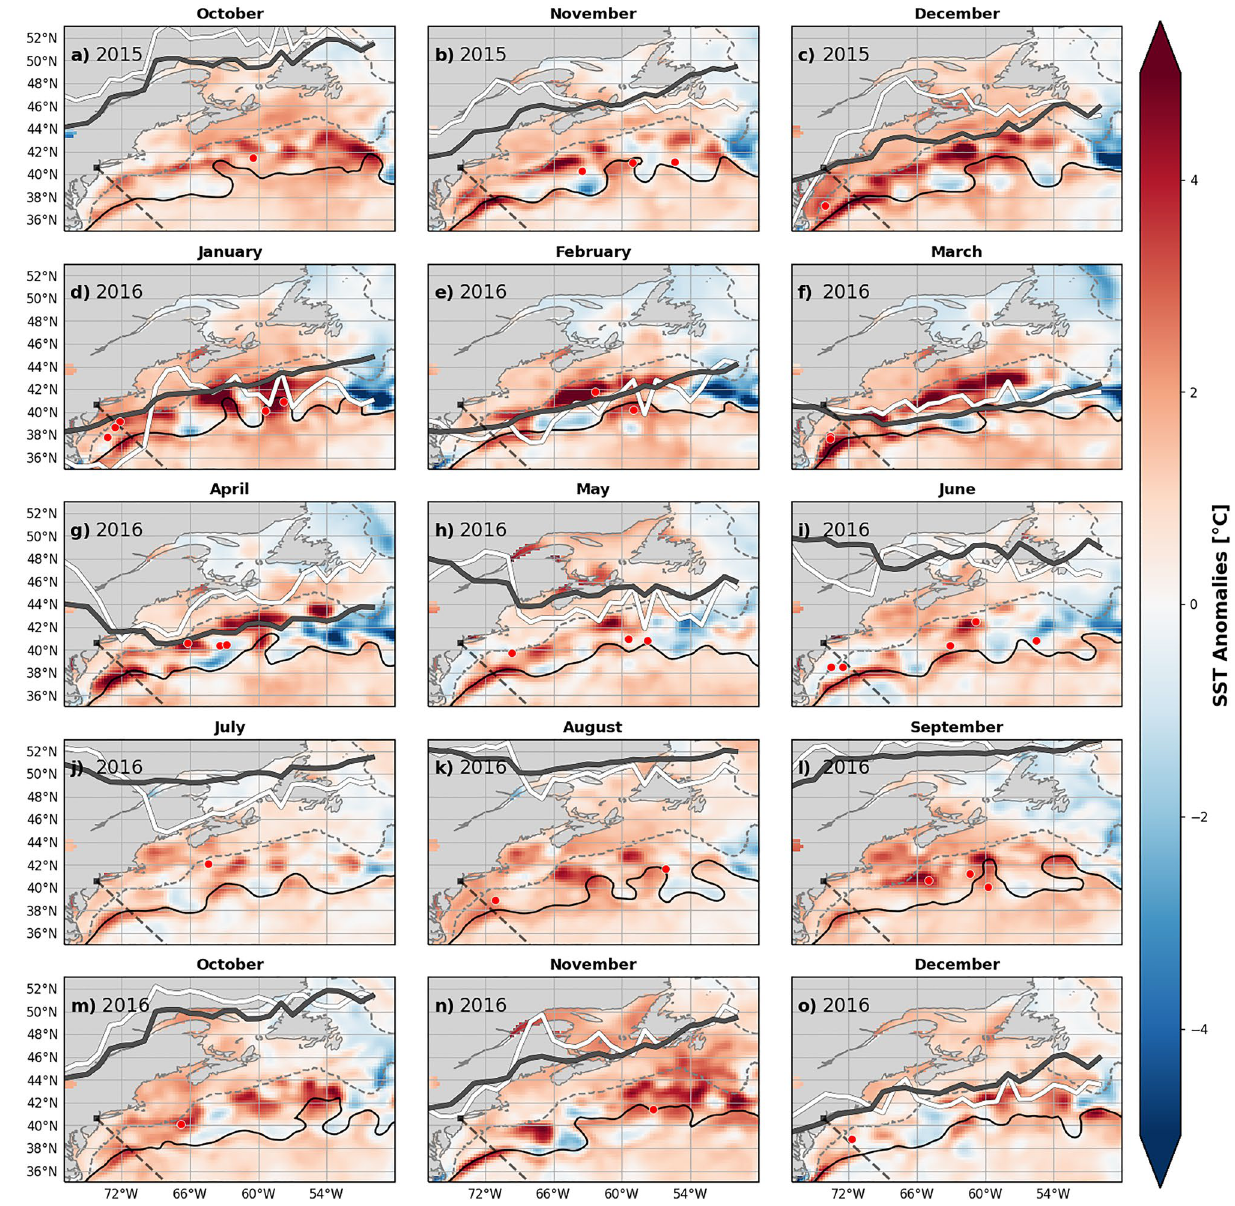
Figure 3. SST anomalies in the NWA for the 15-month period 2015/16. Black dashed line indicates the Oleander Line. Black solid curve indicates the average Gulf Stream path (based on 25 cm SSH isoline) for each month. Positions of WCRs on their date of absorption for the 15-month period are indicated with red dots. Gray dashed line is the isobath contour at 500 m. The thick gray line is the climatological position of the jet stream (1986–2016). The thick white line is the jet stream’s latitudinal position for 2015/16. These maps were generated using Python version average. December has the fewest, with about 1 WCR formation on average 10 . Interestingly, 3 of those 7 WCRs formed in December 2015 were absorbed back into the Center and South Slope in early January 2016 (Fig. 3d, red dots). In total, 5 WCRs were absorbed into the Center and South Slope in January, which is about 4 more WCRs than usual (Fig. 5) and therefore likely contributing to the observed temperature anomalies. The sub-region that experienced the most intense MHW during the winter 2015/16 was the Center Slope with a “strong” MHW that lasted 59 days, from December to January, with a mean SST of 13.4 °C (2.8 °C anomaly). The South Slope also experienced a “strong” MHW that lasted 44 days around the same time period, with a mean SST of 16.4 °C (2.4 °C anomaly). Concurrently the Center and South Shelf experienced MHWs, although the Center Shelf only experienced a “moderate” MHW. The South Shelf also experienced a “strong” heatwave that lasted 40 days from December to January and had an area-averaged SST of 11.9 °C (2.6 °C anomaly). This implies the impact of the warm slope waters on the continental shelf temperatures. Besides the anomalous posi- tion of the jet stream in December 2015, there are not many other anomalies/variability of the jet stream for